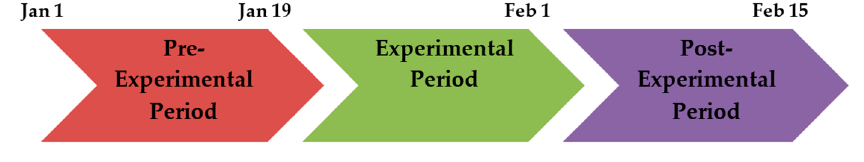
Figure 5. Winter time chart.